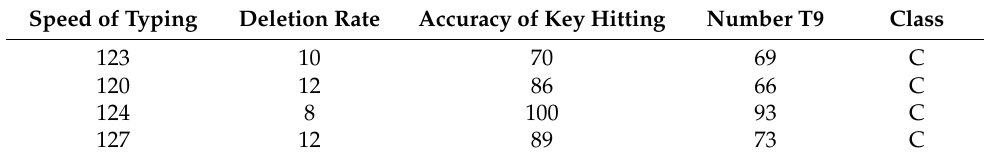
Table 2. Test data of the first set. Speed of Typing Deletion Rate Accuracy of Key Hitting